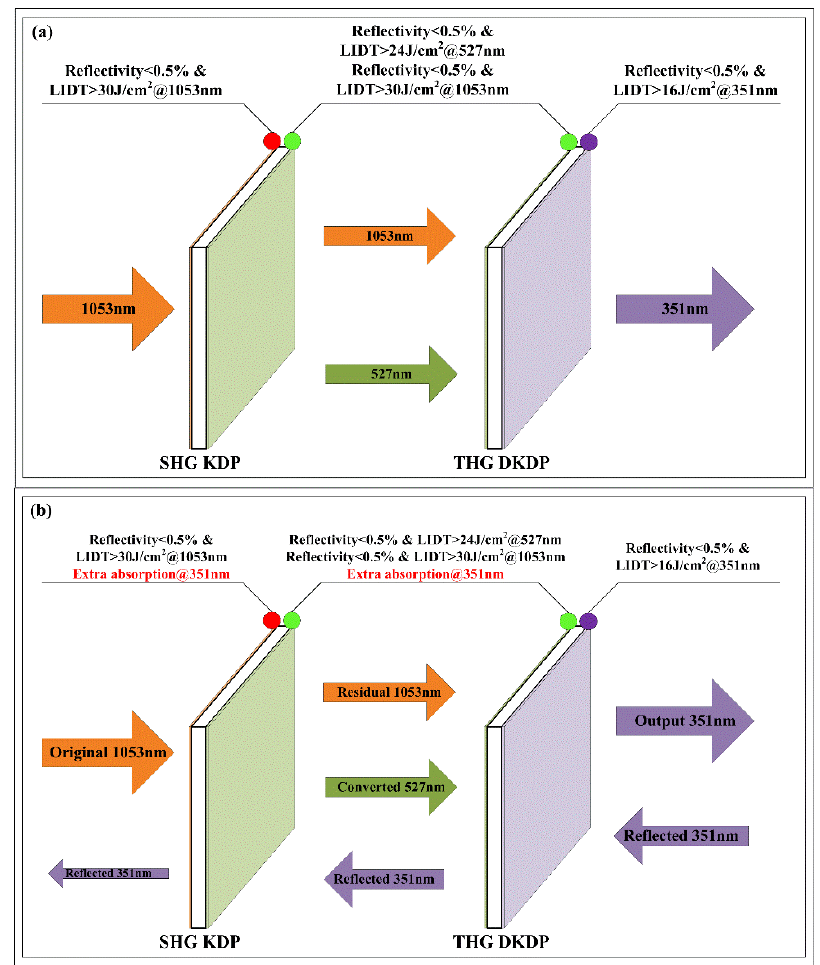
Figure 1. Schematic diagram of the frequency-converting pair (FCP) in one laser beam from high-power laser system, ( a ) original design; ( b ) optimized design.